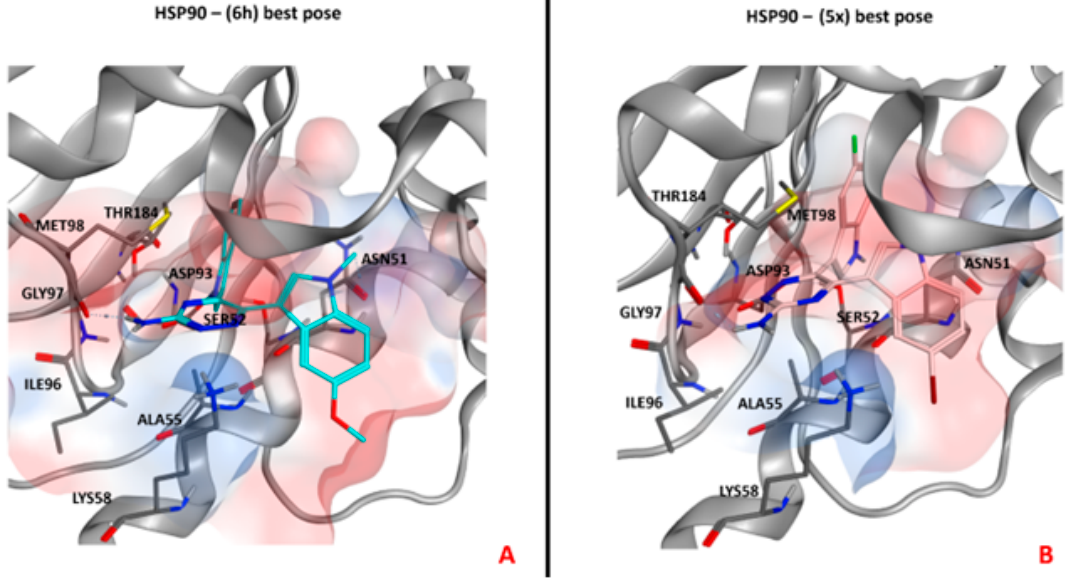
Figure 6. Depiction of the binding mode of the two compounds chosen as the reference for our study in the orthosteric HSP90 binding site, which also has the electrostatic surface highlighted. ( A ) Representation of the binding pocket’s electrostatic surface for the selected pose produced by molecular docking of the ligand 6h (colored cyan), which has passed through the steric, electrostatic, and pharmacophoric filtering procedures. ( B ) Representation of the binding pocket’s electrostatic surface for the selected pose produced by molecular docking of the ligand 5x (colored in pink), which has passed through the steric, electrostatic, and pharmacophoric filtering procedures. The images were created and rendered with